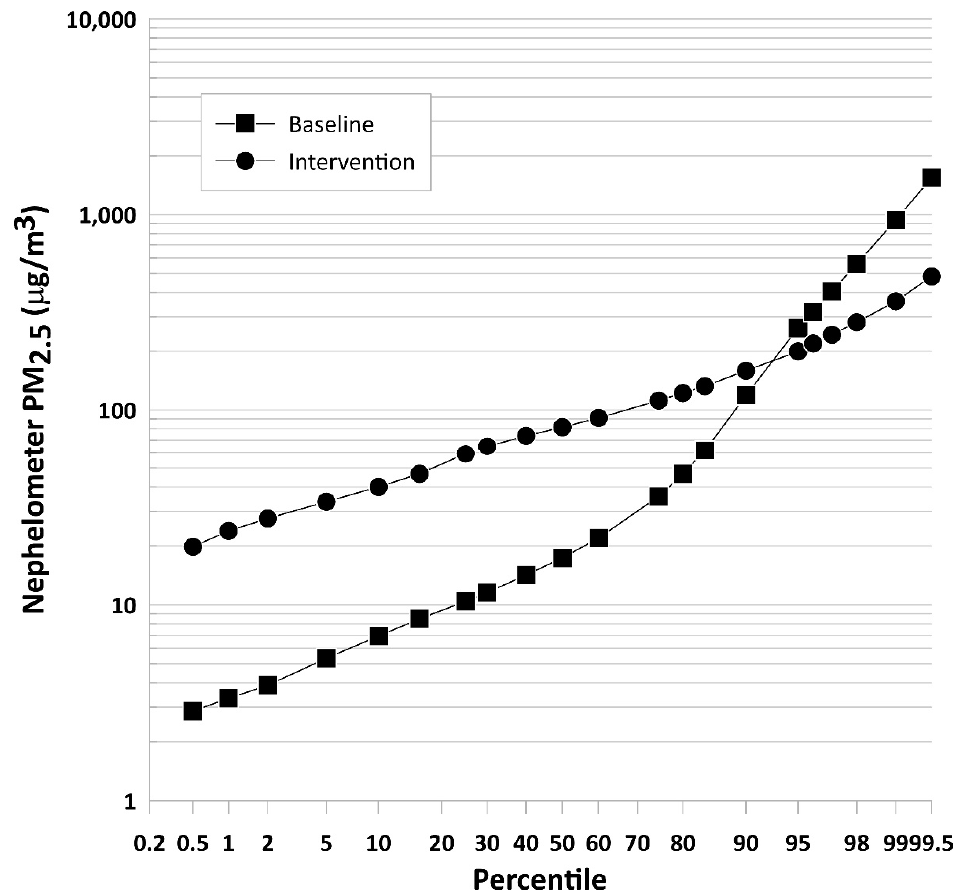
Figure 1. Probability distribution of the valid, 1 min average PM 2.5 nephelometer concentrations measured during baseline and intervention. The percentiles are the fraction of the exposure data less than the corresponding concentration.